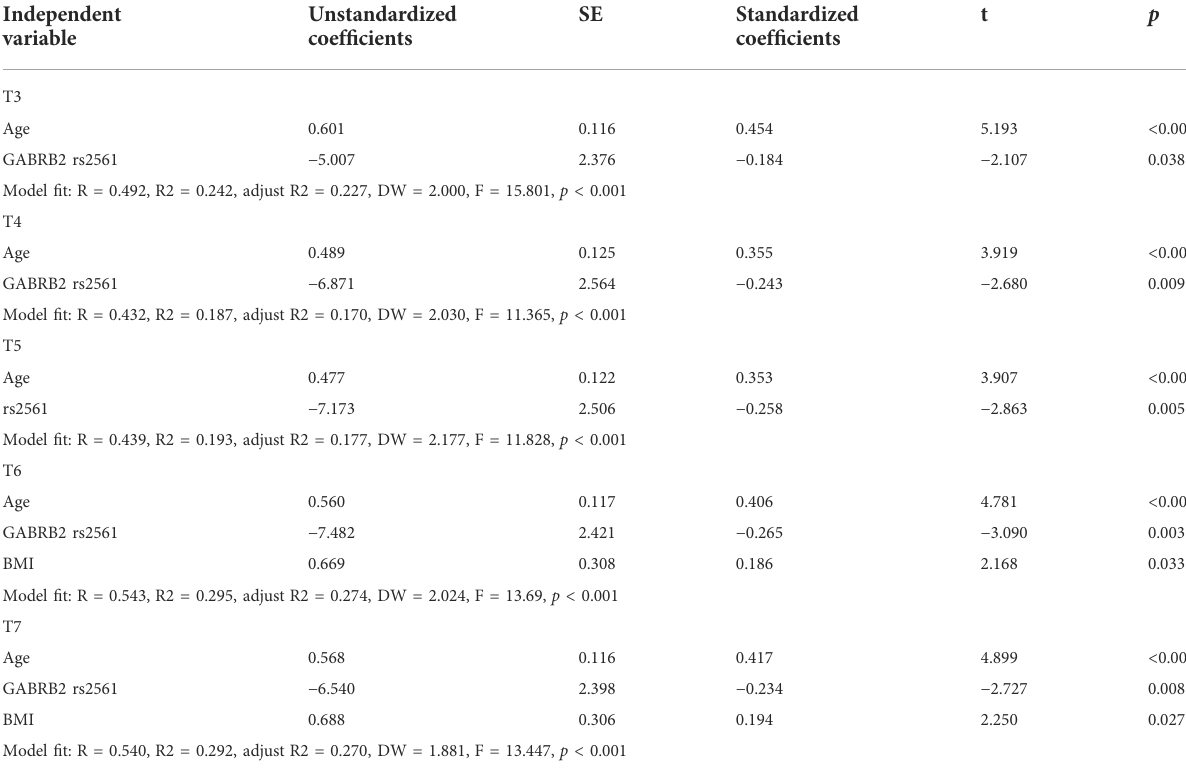
TABLE 5 Multiple linear regression analysis of clinical variables related to